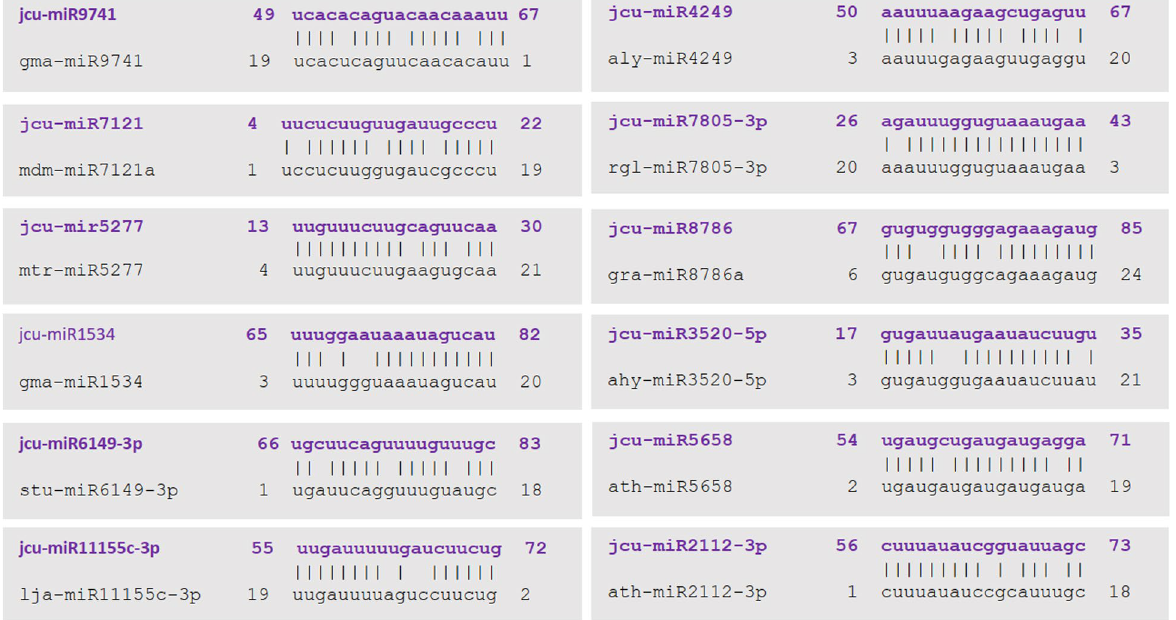
Fig. 3 Alignments of the putative miRNAs of J. curcas and its homologs from respective microRNA family